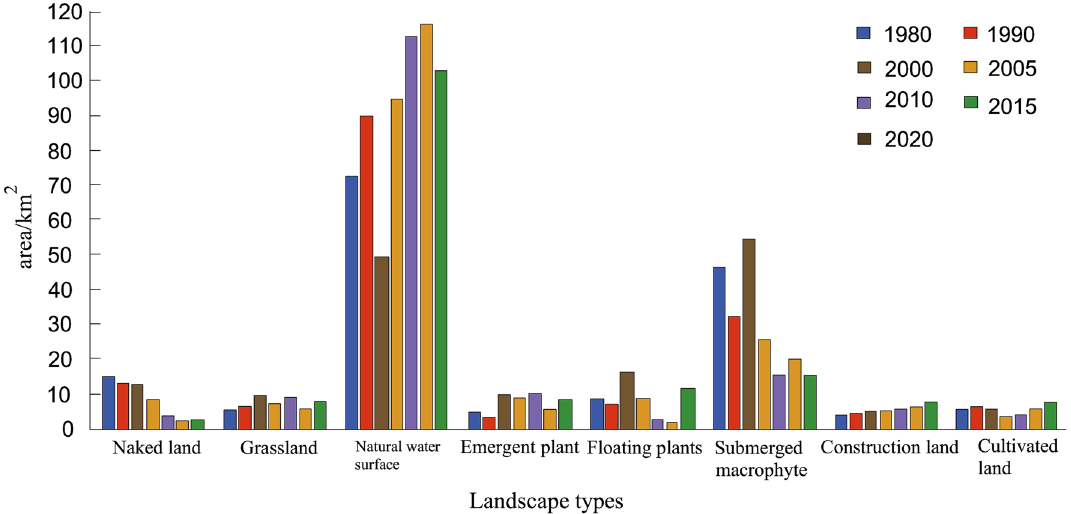
Fig. 3 Variation comparison among different types of wetland landscape in the Dongping